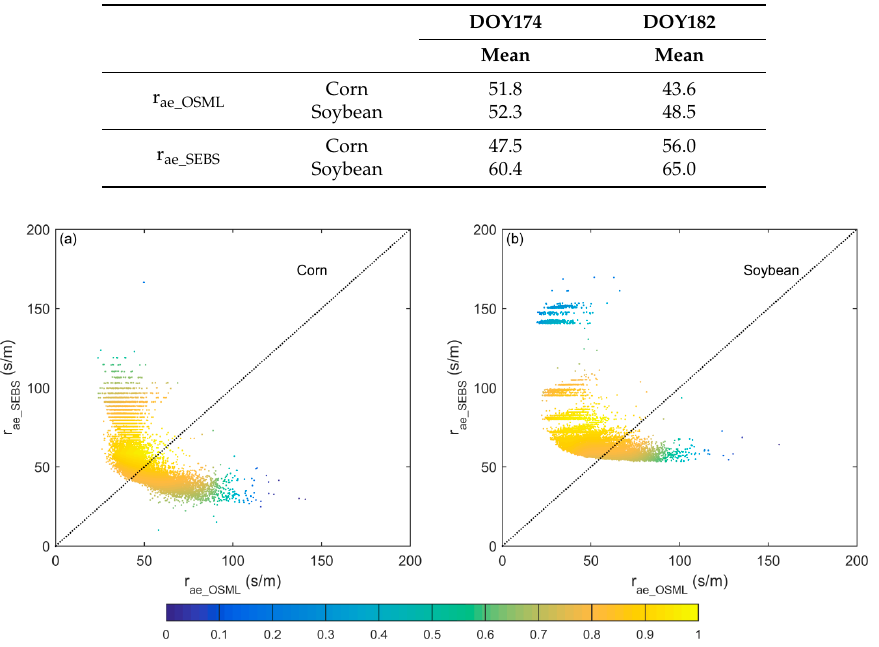
Table 4. Statistics for regional-scale r ae_OSML and r ae_SEBS for cornfields and soybean fields (s/m).